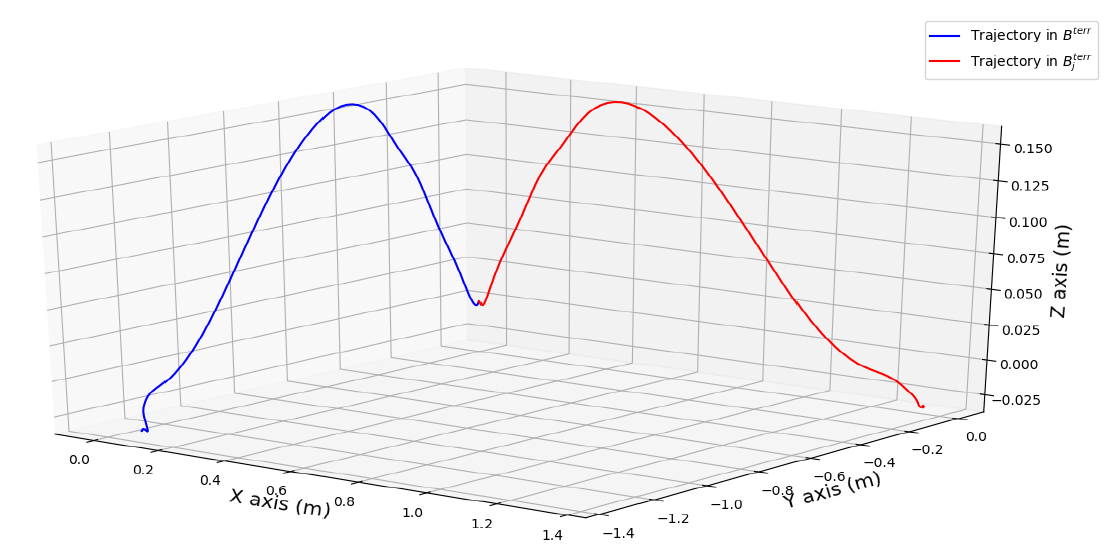
Figure 4. Example of a computed pseudo-trajectory in B terr and B terr